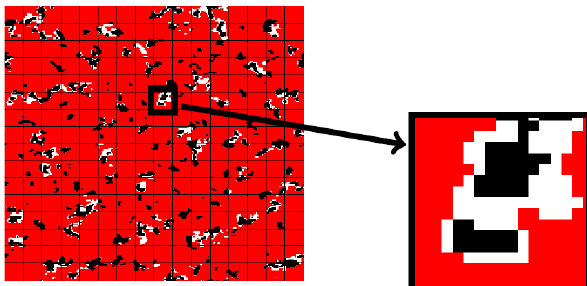
Figure 1. 16km long horizontal cross section of an LES (IHOP case, 14:00LT, 500m altitude) and 1km long zoom. The thermal fraction is in white, the core of the thermals (strong vertical veloc- ity) is in black, and the environment is in red (see Honnert et al.,